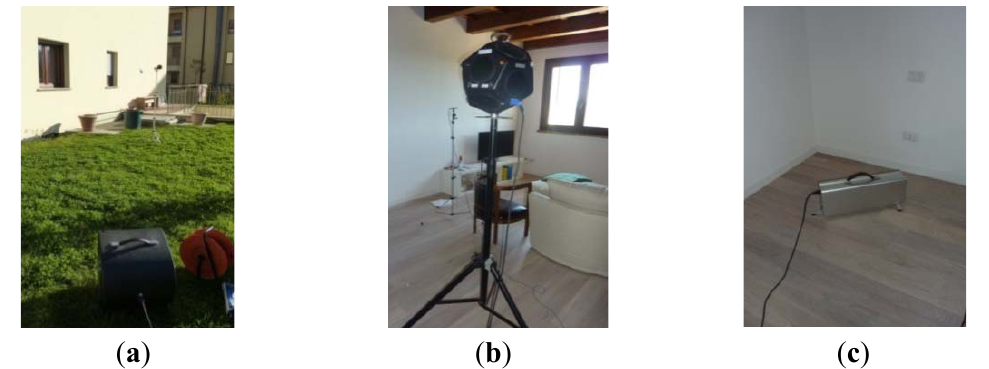
Figure 5. Experimental acoustic campaign in the investigated buildings: ( a ) façade sound insulation; ( b ) airborne sound insulation between rooms; and ( c ) impact sound insulation of